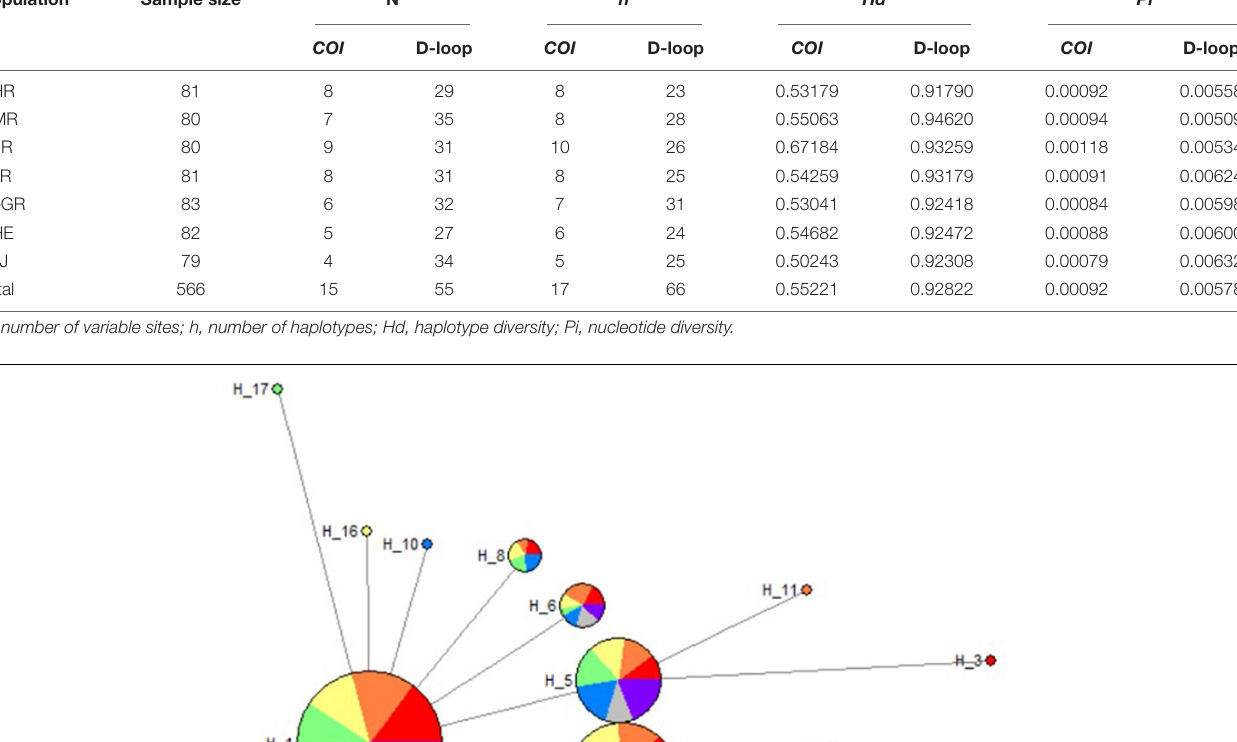
TABLE 3 | Genetic diversity indices of G. przewalskii populations by two mitochondrial markers. Population Sample size